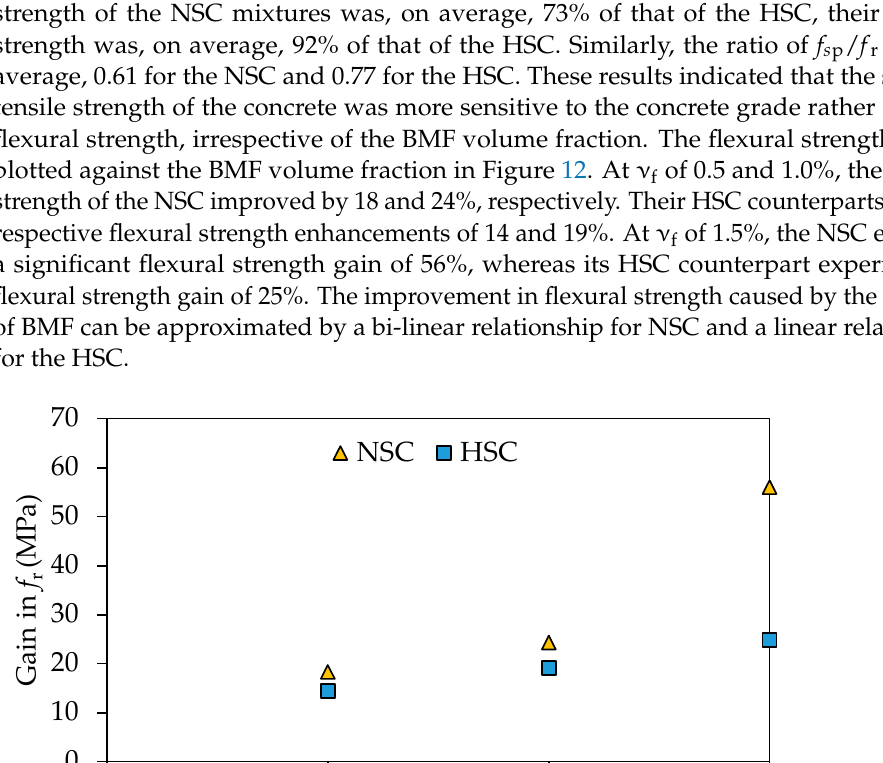
Figure 11. Failure mode of splitting tensile test specimens: ( a ) NSC-BMF0.0; ( b ) NSC-BMF0.5; ( c ) HSC-BMF0.0; ( d ) HSC-BMF0.5.